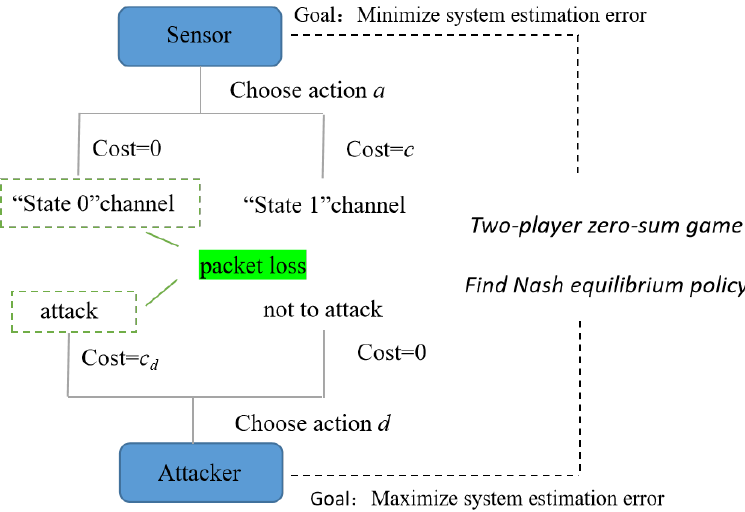
Figure 2. The zero-sum game between sensor and DoS